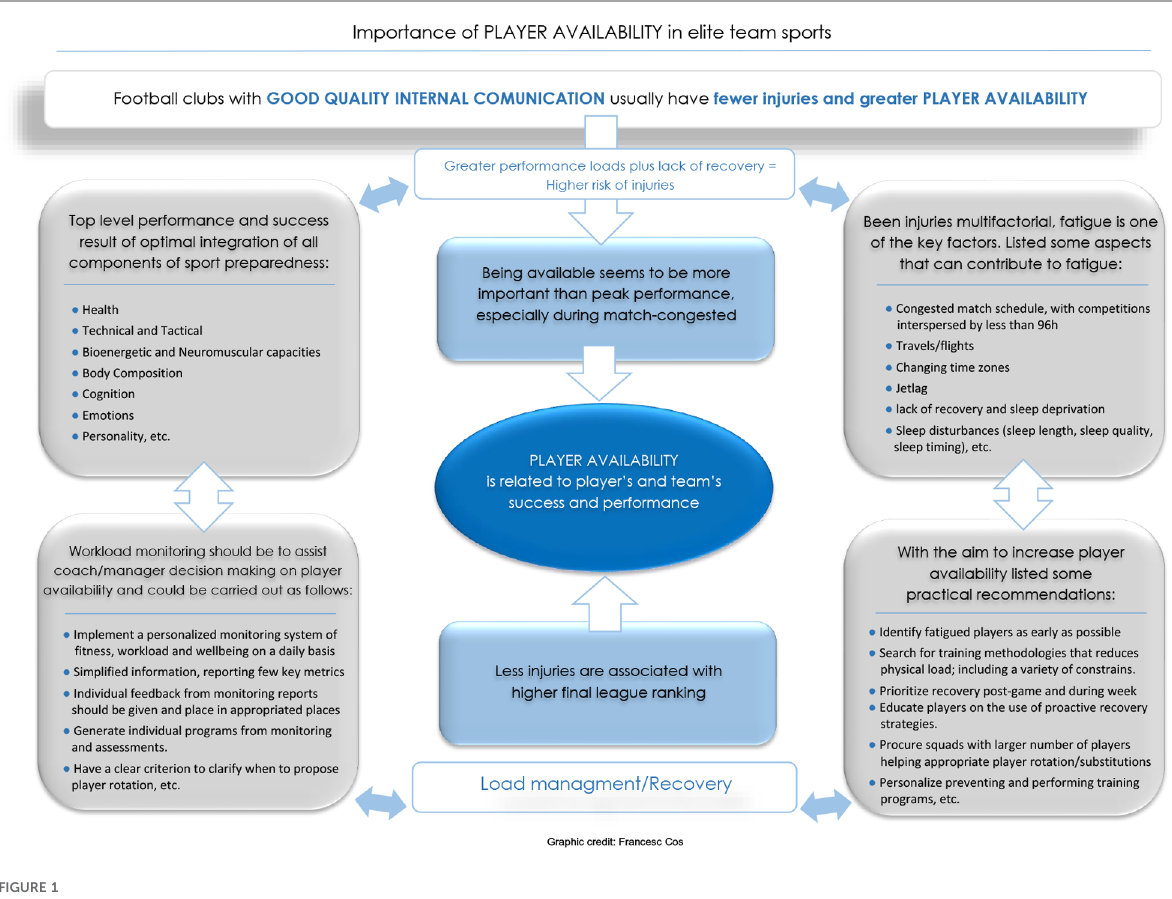
FIGURE 1 Importance of PLAYER AVAILABILITY in elite team